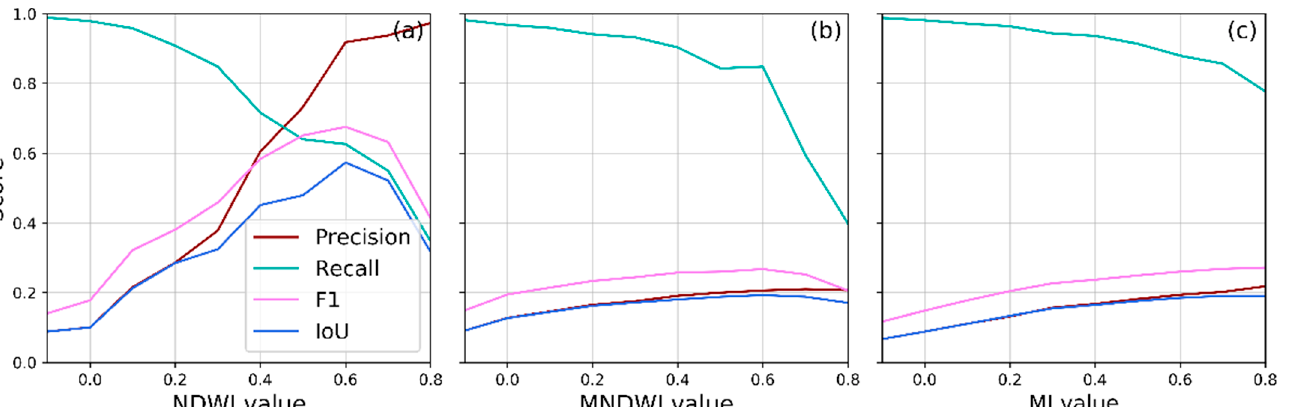
Table 2. Ablation results of using different loss terms.